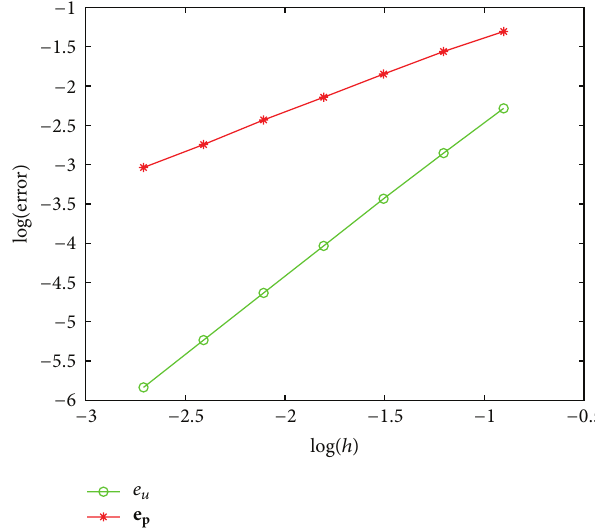
Figure 3: The convergence rates of 𝐿 2 norm in the exact 𝑢 and its flux p for 𝛽 1 : 𝛽 2 = 1:10.